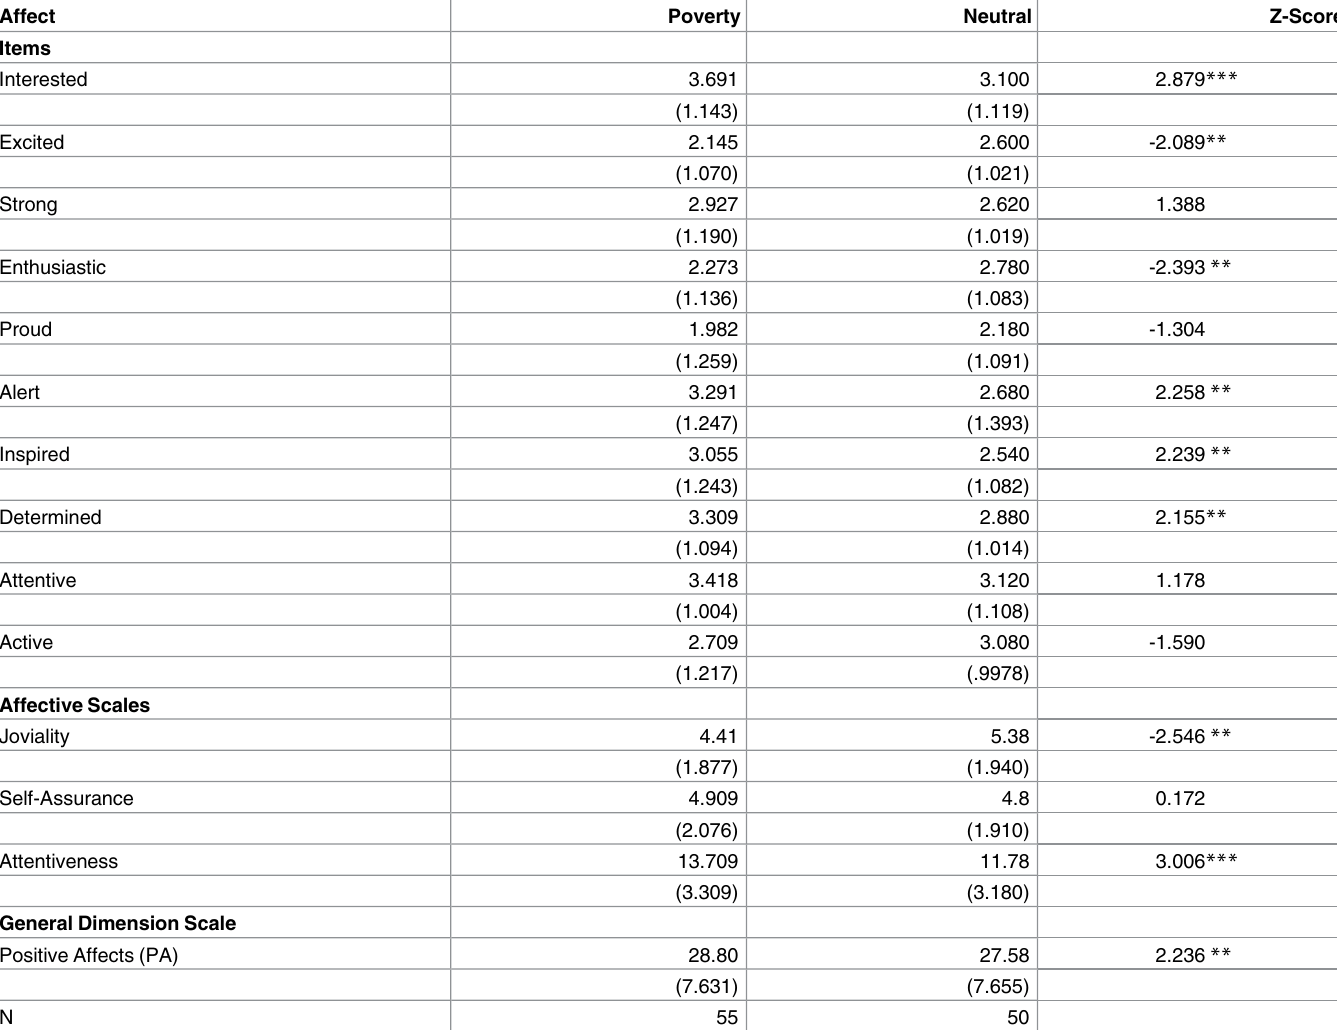
Table 2. Averageand Standard Deviation of Positive Affect Scales, by